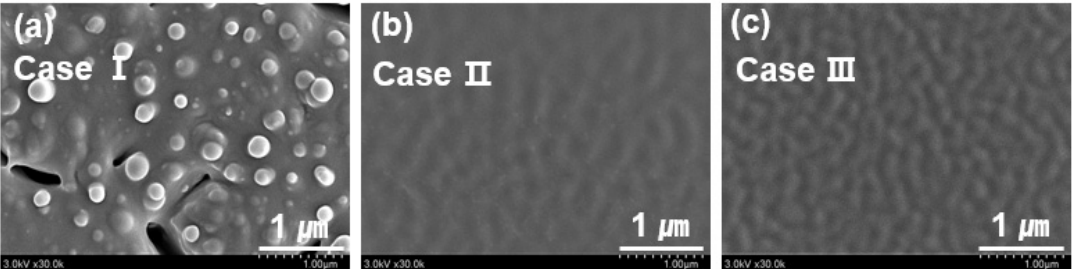
Figure 6. FE-SEM images of PANI thin films prepared using APPR with pin electrode under optimal conditions with respect to three electrode configurations of ( a ) cases I, ( b ) II, and ( c ) III.